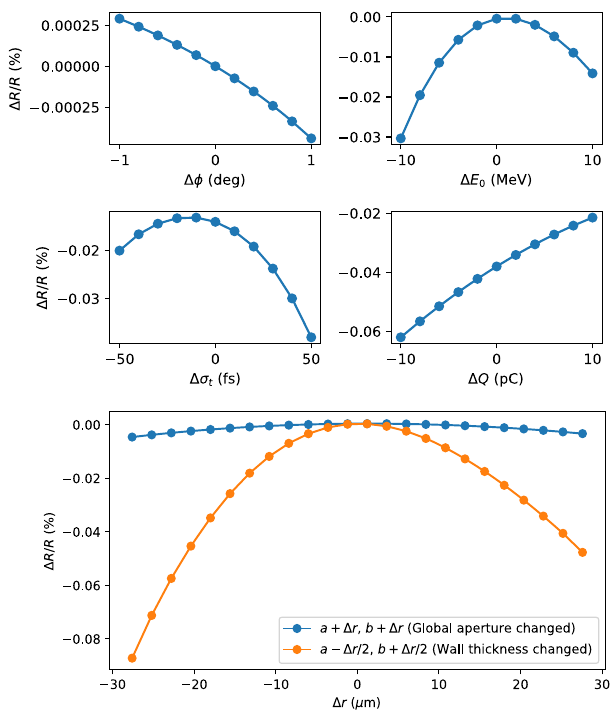
FIG. 15. Top four plots: relative change of the linearity factor R vs four different parameters, which influence the input LPS. Bottom plot: relative change of the linearity factor R vs a constant error Δ r for two different systematic manufacturing error scenarios. The same Δ r is applied to all